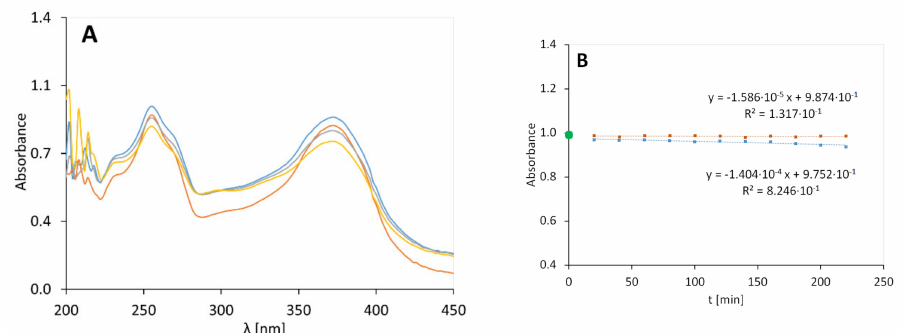
Figure 1. The graph on the left ( A ) shows the spectra of quercetin in ethanol solution (QA) exposed to radiation after 0 ( - ), 80 ( - ), 120 ( - ), and 200 ( - ) minutes. The graph on the right ( B ) shows the UV-induced quercetin ethanol solution degradation (orange dots are used for the results of the unexposed samples and blue dots are used for the result obtained for the irradiated